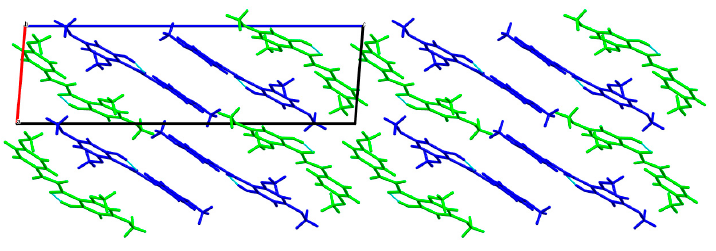
Figure 7. ORTEP representation of the asymmetric unit of HCH ( a ), IBC ( b ) and CA ( c ), showing the non-hydrogen atom-numbering scheme. Displacement ellipsoids are drawn at the 50% proba- bility level.